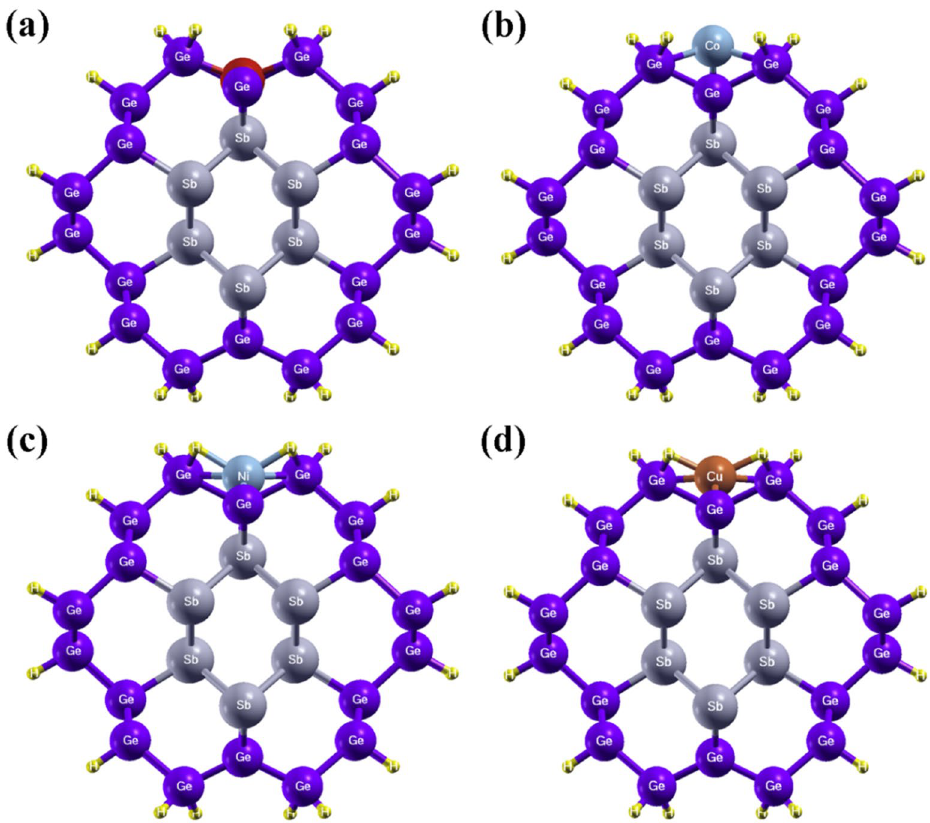
Figure 6. Optimized atomic structure of ( a ) Fe, ( b ) Co, ( c ) Ni and ( d ) Cu doped Sb/Ge NWs in the presence of the Sb vacancy in the